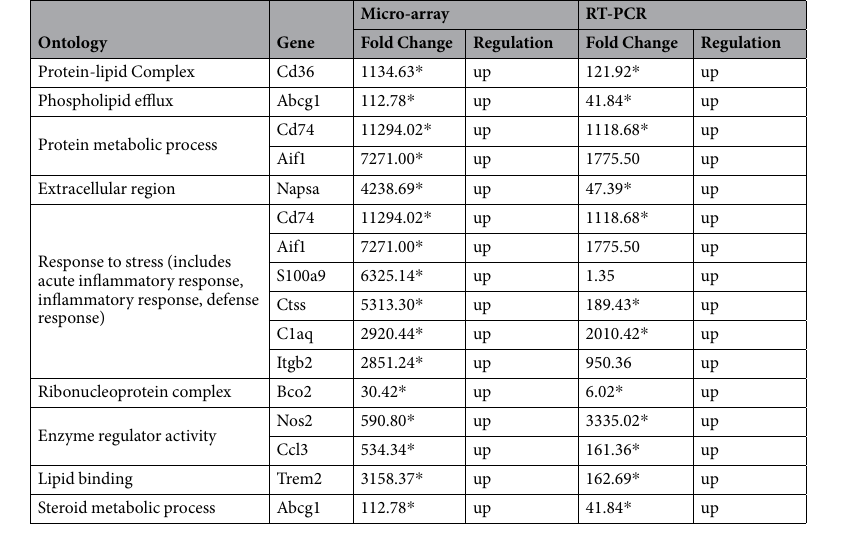
Table 1. Validation of micro array data with RT-PCR- * P < 0.05.